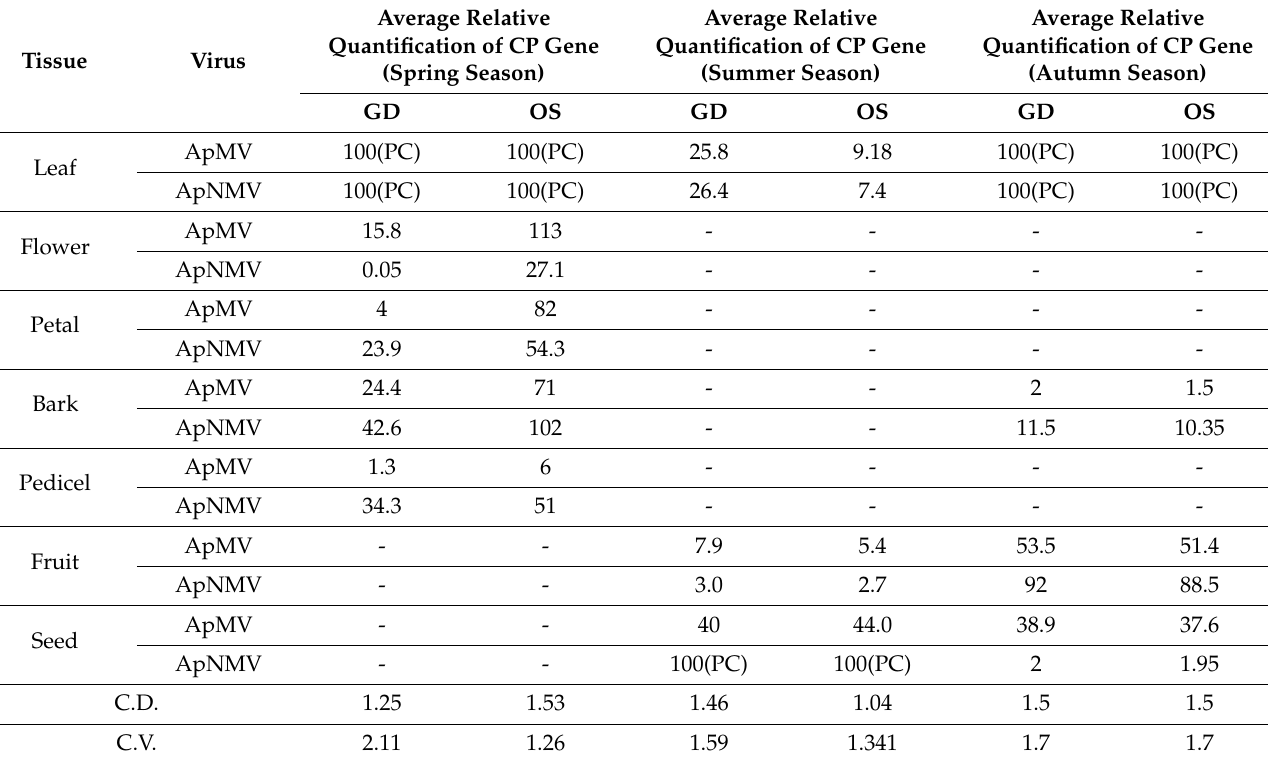
Table 2. Relative quantification of ApMV and ApNMV in different tissues of two cultivars of Golden Delicious and Oregon Spur apple cultivars during the spring, summer and autumn